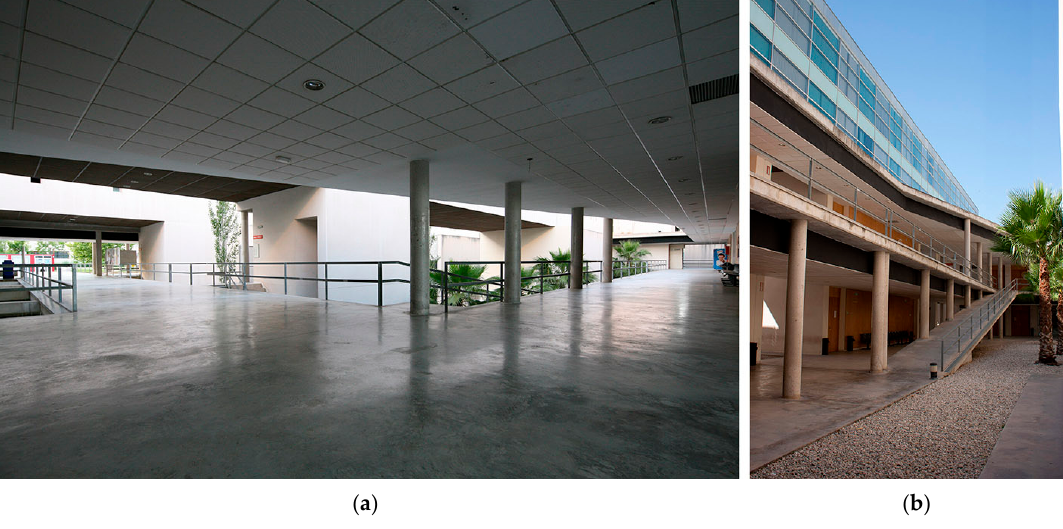
Figure 7. HPS IV: View of the ground floor passage ( a ) and ramp ( b ) linking it to the basement. Photos: Courtesy of UA’s Technical Office.